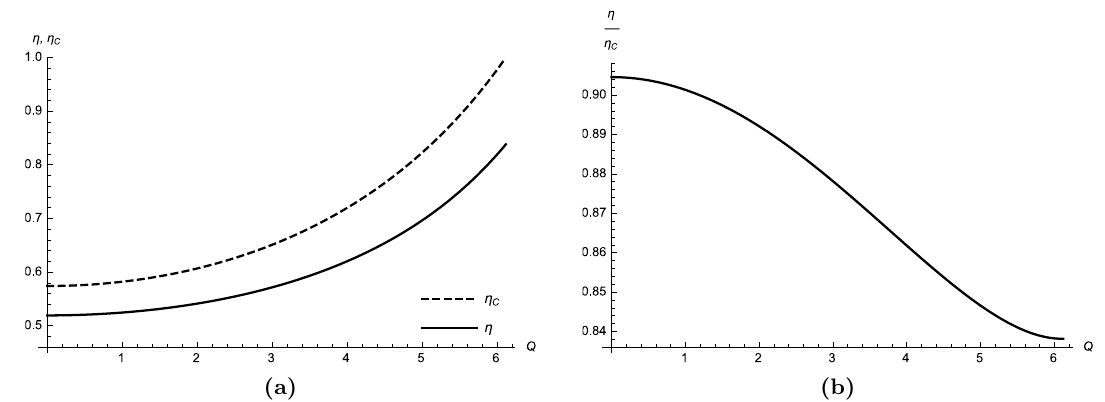
Figure 3 . A speci(cid:12)c example of four-dimensional charged black holes with the parameters chosen as k = 1 ; c 0 = 1 ; c 1 = (cid:0) 2 ; c 2 = (cid:0) 3 ; P 1 = 2 ; P 4 = 1 ; m 2 = 1 ; S 1 = 8 ; S 2 = 10. (a) (cid:17); (cid:17) C as the function of Q . (b) (cid:17)=(cid:17) C as the function of Q